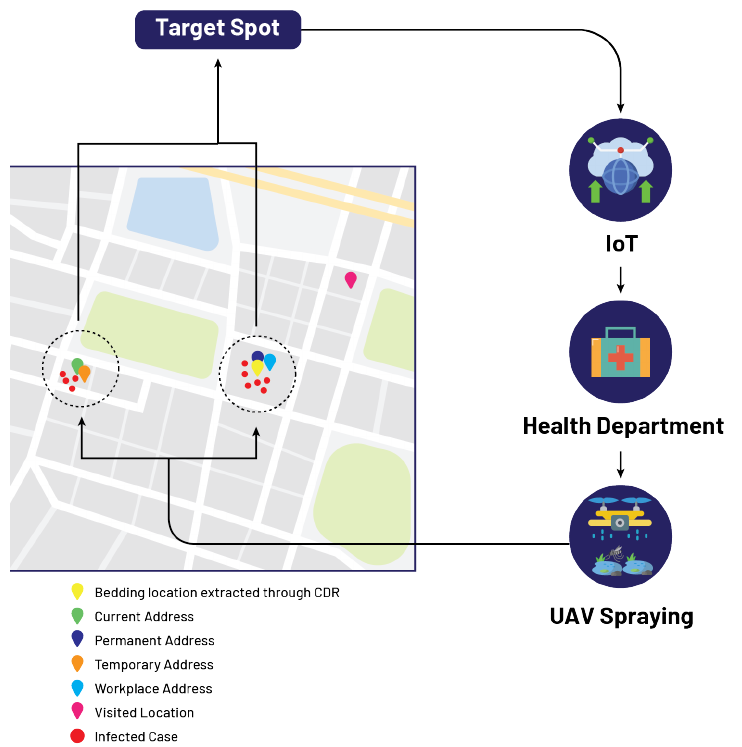
Figure 7. Localization of target spots based on proposed model.